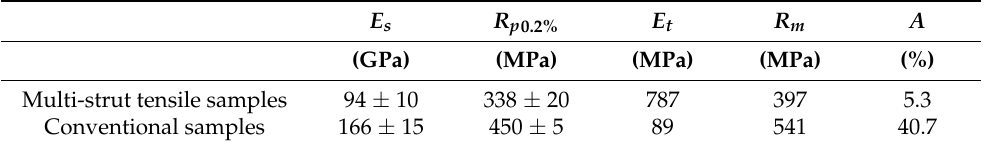
Table 3. Comparison of mechanical properties of conventional samples and samples with thin